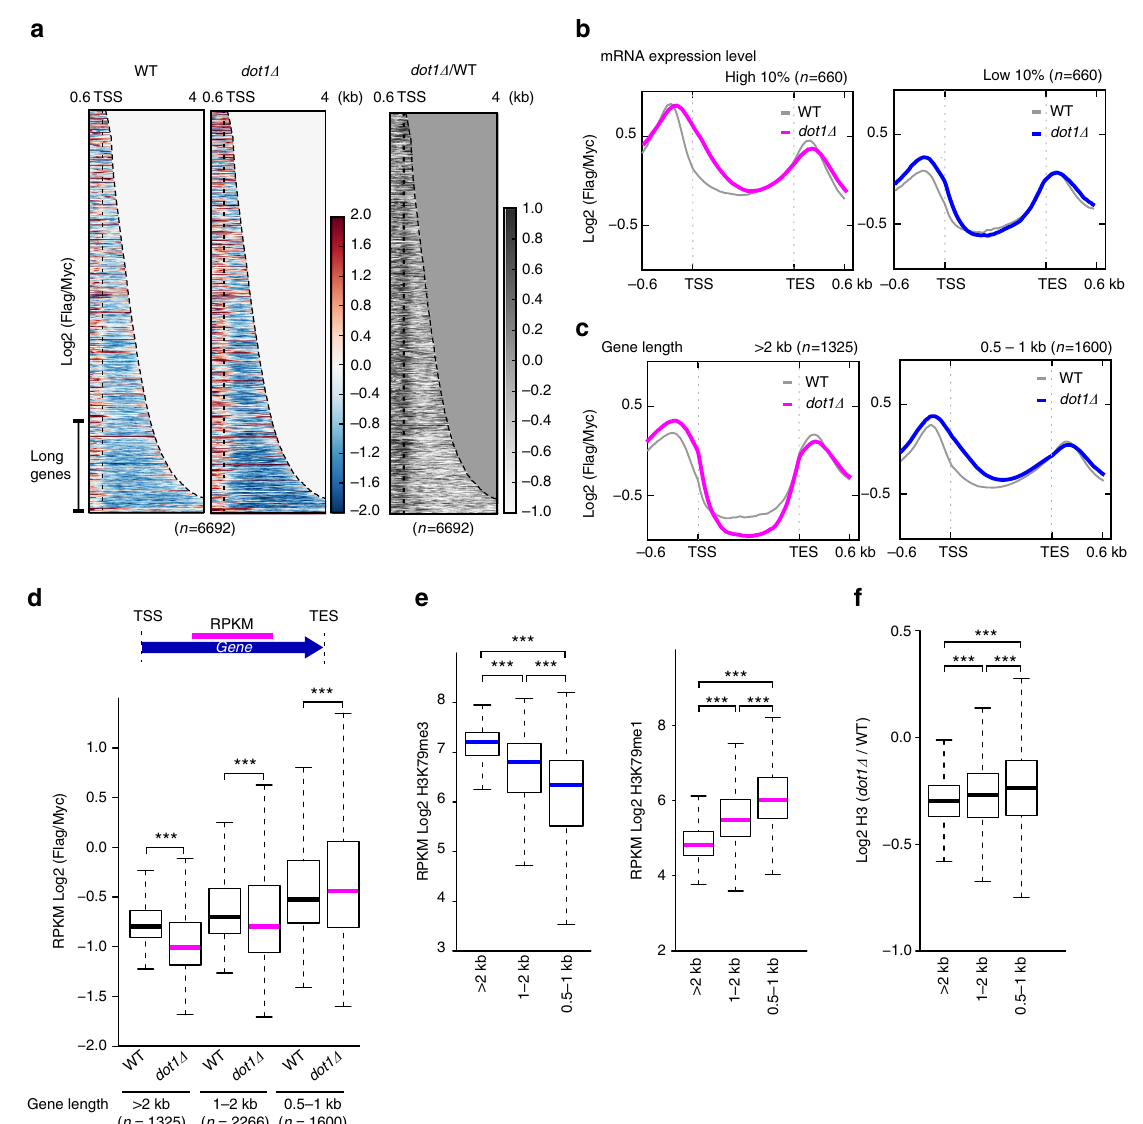
Fig. 5 Dot1p preferentially affects histone exchange in long genes. a Heatmap of histone exchange (log 2 Flag ChIP/Myc ChIP) at all genes of yeast ( n = 6692). The read counts were obtained from biological duplicates. Pro fi les are shown in ascending order of the length of the transcribed region. Dotted lines indicate the TSS. Genes > 2 kb in length are indicated as ‘ Long Genes ’ . The value of the region exceeding the TES is treated as 0. Left, wild-type; center, dot1 Δ ; right, dot1 Δ relative to wild type. The color bar represents value of log > 0, color blue: < 0, for left and center panel; color black: 2 Flag/Myc (color red: > 0, color white: < 0, for right panel). b , c Total genes were clustered based on their b mRNA expression levels and c gene lengths. The gray line indicates the histone exchange rate in wild-type cells. Magenta lines indicate clusters of genes having high mRNA expression levels ( b , n = 660) and those longer than 2 kb in length ( c , n = 1325) in dot1 Δ cells. Blue lines indicate clusters of genes having moderate mRNA expression levels ( b , n = 660) and those of 0.5 – 1 kb in length ( c , n = 1600). The values of the y -axis indicate histone exchange, and the x -axis indicate distance from TSS and TES. d , e *** P -value < 0.001. The upper panel of ( d ) shows a schematic diagram of our analysis. Magenta colored line, the center of transcribed regions, represents the region where taken to be values in the boxplots in ( d , e ). d A boxplot of histone turnover RPKM values obtained at the centers of the transcribed regions in wild- type and dot1 Δ cells for each gene length cluster (i.e., > 2 kb, 1 – 2 kb, and 0.5 – 1 kb). e A boxplot of the RPKM values for H3K79me3 and H3K79me1 at the centers of transcribed regions. Genes are clustered based on gene length as described for ( d ), and the boxplots present H3K79me3 (left) and H3K79me1 (right). f The level of histone H3 is clearly related to gene length. A boxplot presents the log 2 fold change of H3 in dot1 Δ versus wild-type cells at